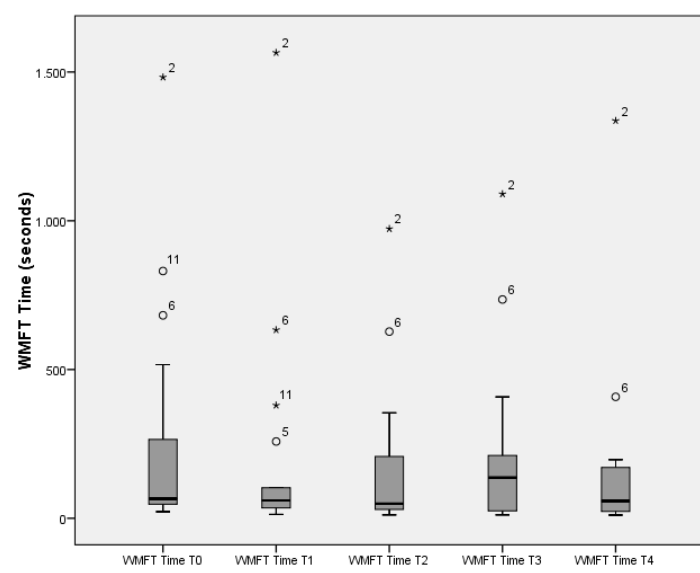
Figure 2. Plotted data of WMFT time.